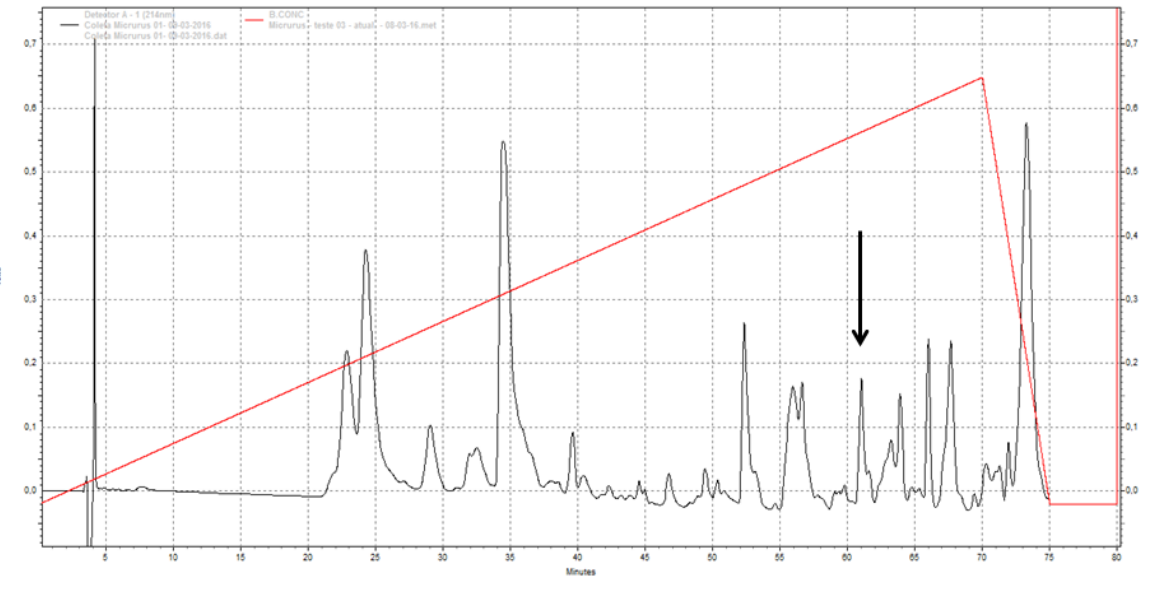
Figure 1. Crude venom purified on high performance liquid chromatography (HPLC) using a C8 column on a Prominence binary system (Shimadzu). The venom components were eluted with a flow rate of 1 mL/min with solvents A [0.1% trifluoroacetic acid (TFA) in deionized H TFA in deionized H O) with gradient from 10 to 35% of solution B, represented by the trace. The absorbance was read at 214 nm. In the highlighted area, the 2 arrow indicates the fraction that contains the Mlx-8 with a retention time of 61 minutes in 75 minutes